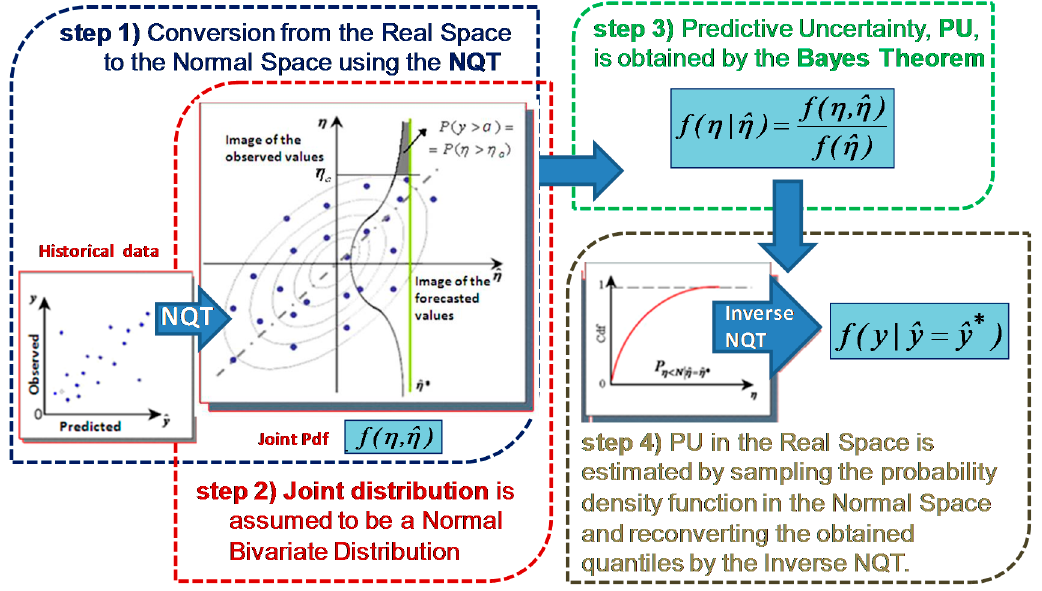
Figure 1. Schematic diagram of the four main steps of the MCP for Predictive Uncertainty estimate.